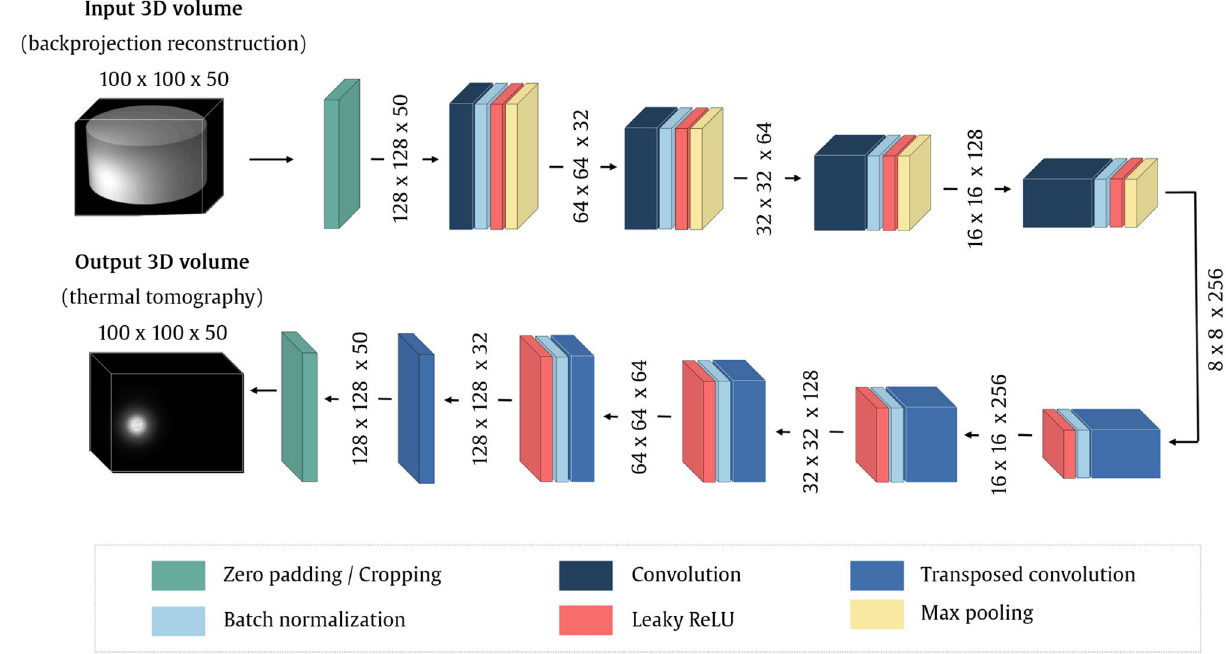
Figure 4. General scheme of the CNN model for thermal model